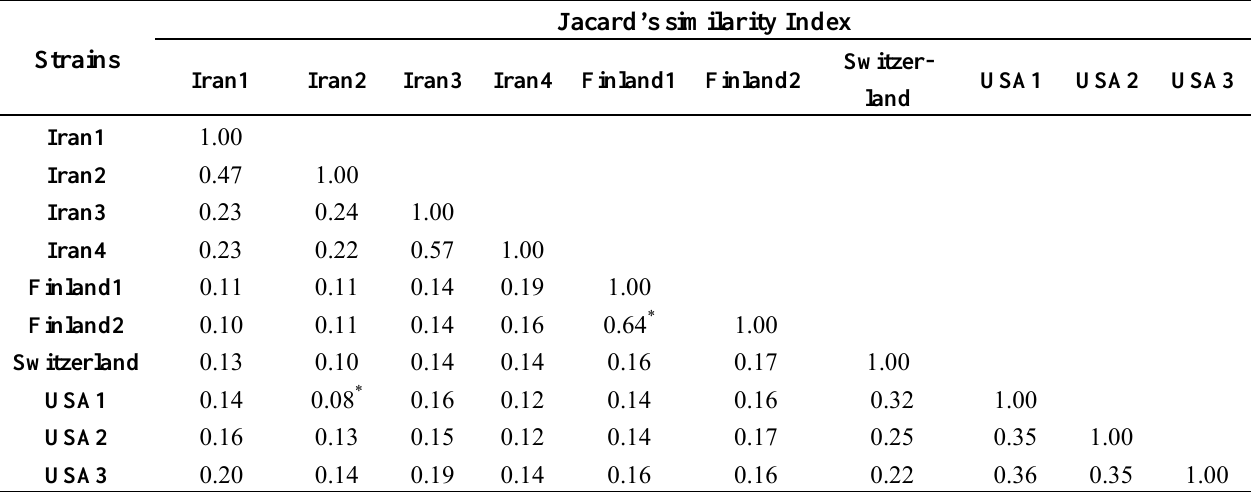
Table 1. The Jacard’s similarity index among ten strains of Haematococcus pluvialis. Jacard’s similarity Strains